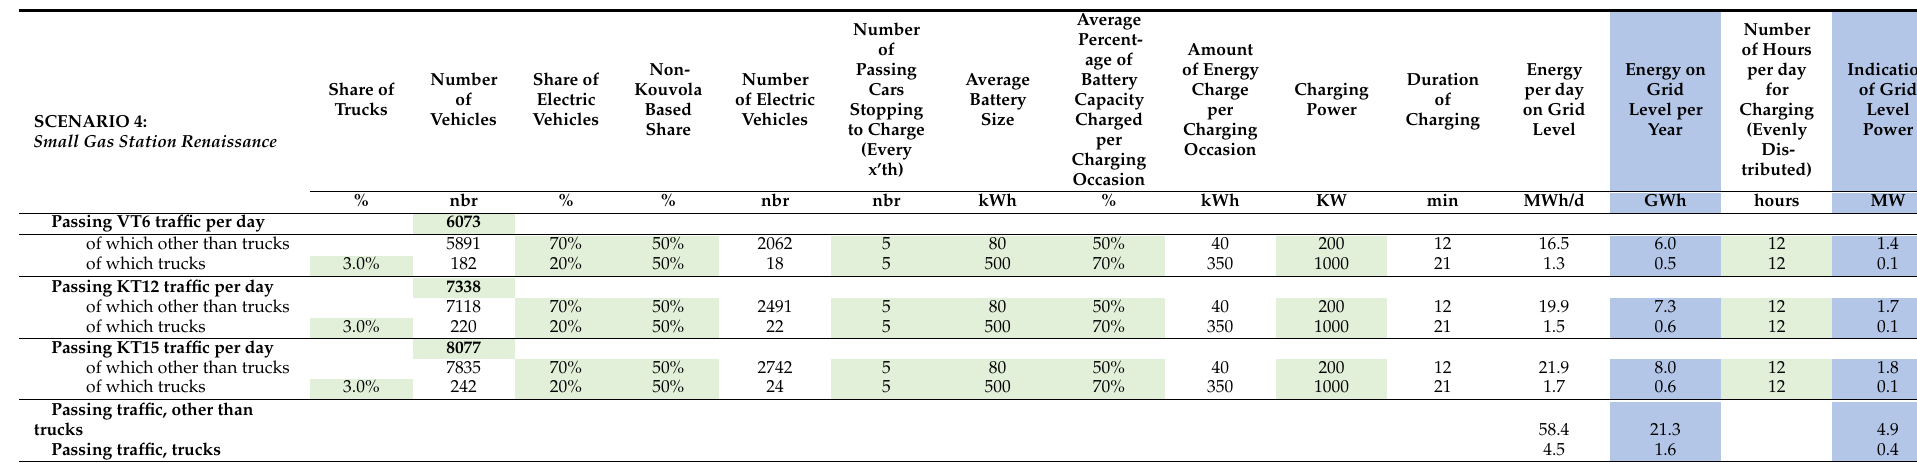
Table A12. Detailed quantification of passing traffic (the derived additional energy is consolidated into the summary (Table A10) on the top and subdivided into user groups in Table